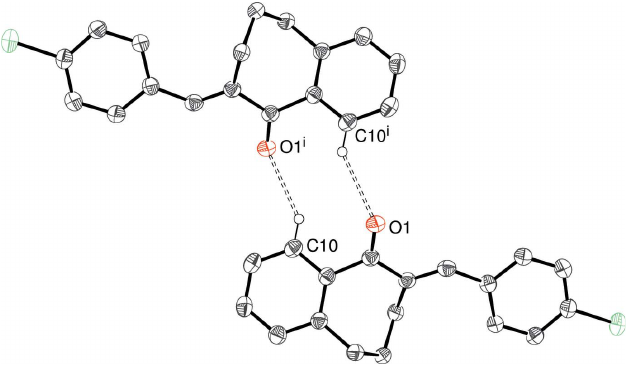
Figure 10 Fragment of the crystal structure of (IV), showing inversion dimers linked